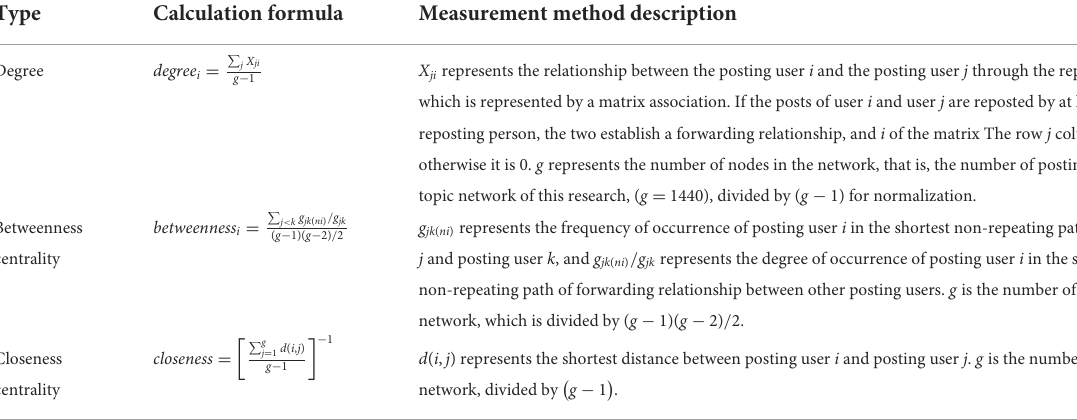
TABLE 1 Method to measure the effectiveness of social network nodes.